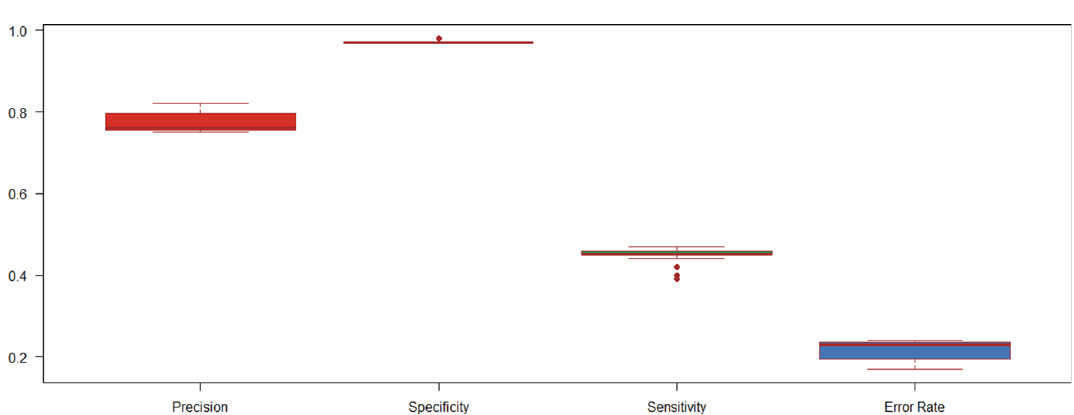
Figure 3. Sensitivity, Specificity, Precision, and Error Rate for HHblits runs using different E-value thresholds, number of iterations, and MACT values are given in the box